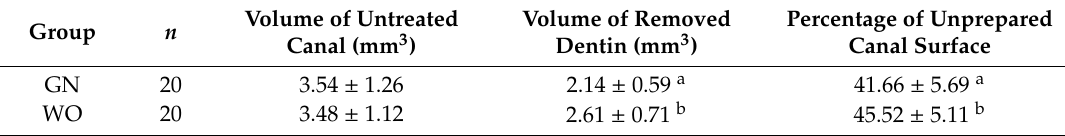
Table 1. Mean values and standard deviations (SD) of the di ff erences in 3D parameters between experimental